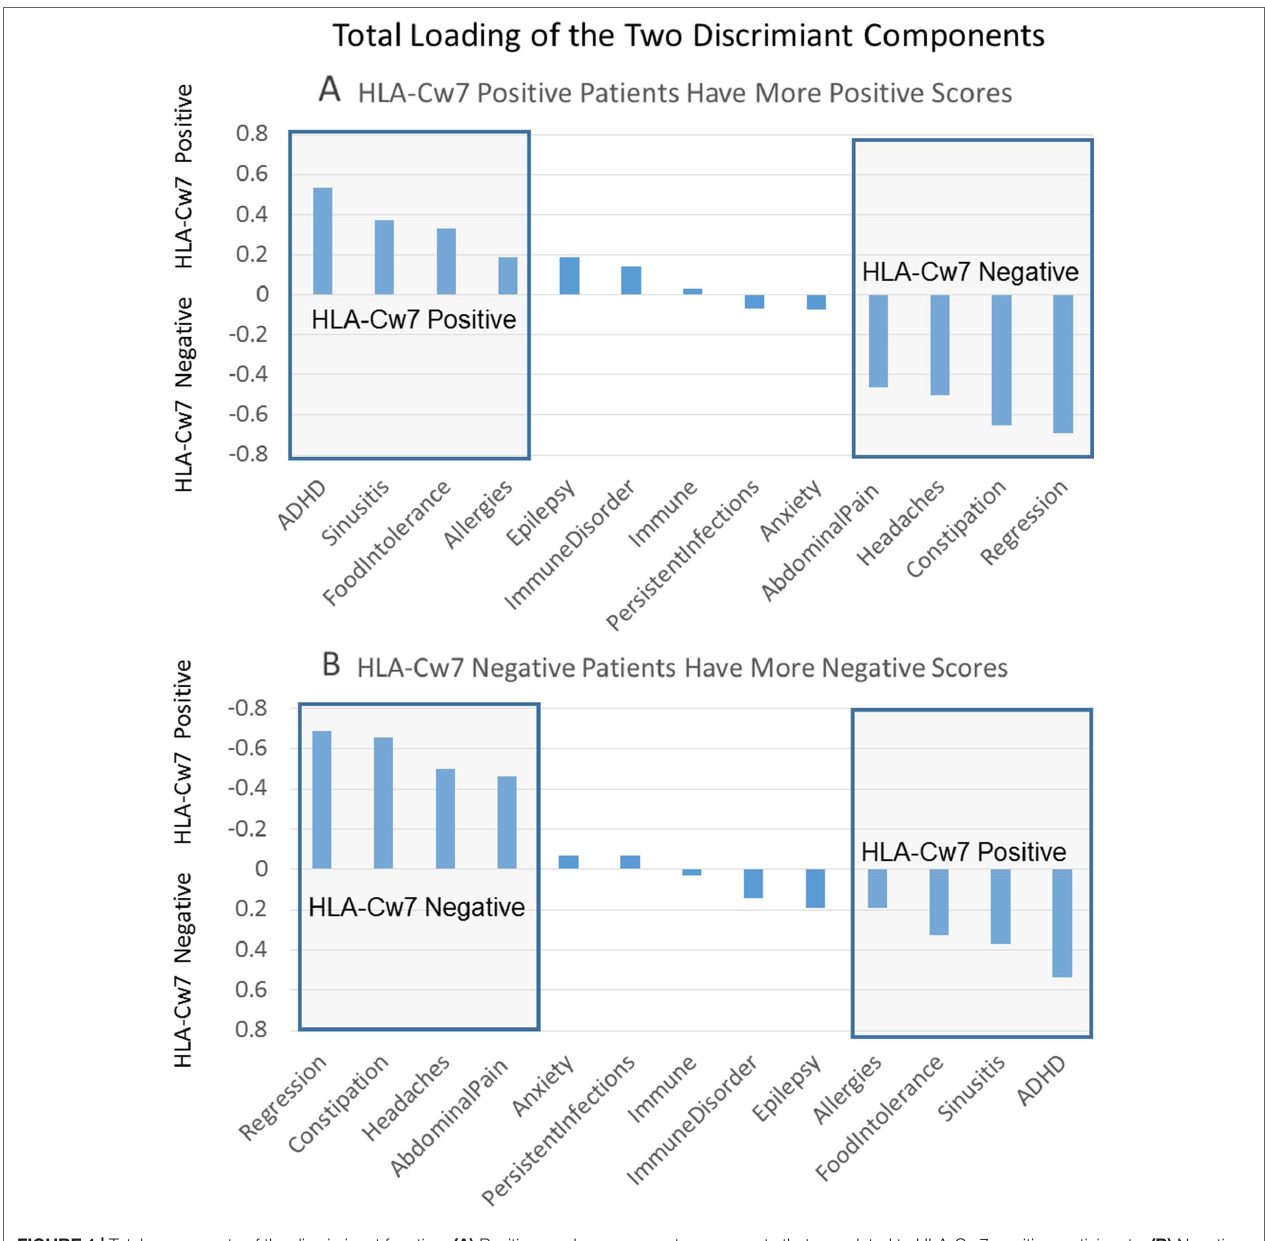
FIGURE 1 | Total components of the discriminant function. (A) Positive numbers represent components that are related to HLA-Cw7-positive participants. (B) Negative numbers represent components more representative of the HLA-Cw7-negative